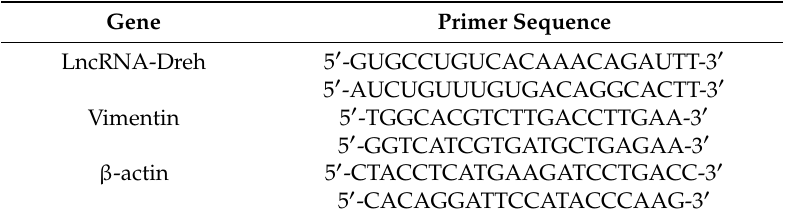
Table 1. Primer sequences for reverse transcription quantitative polymerase chain